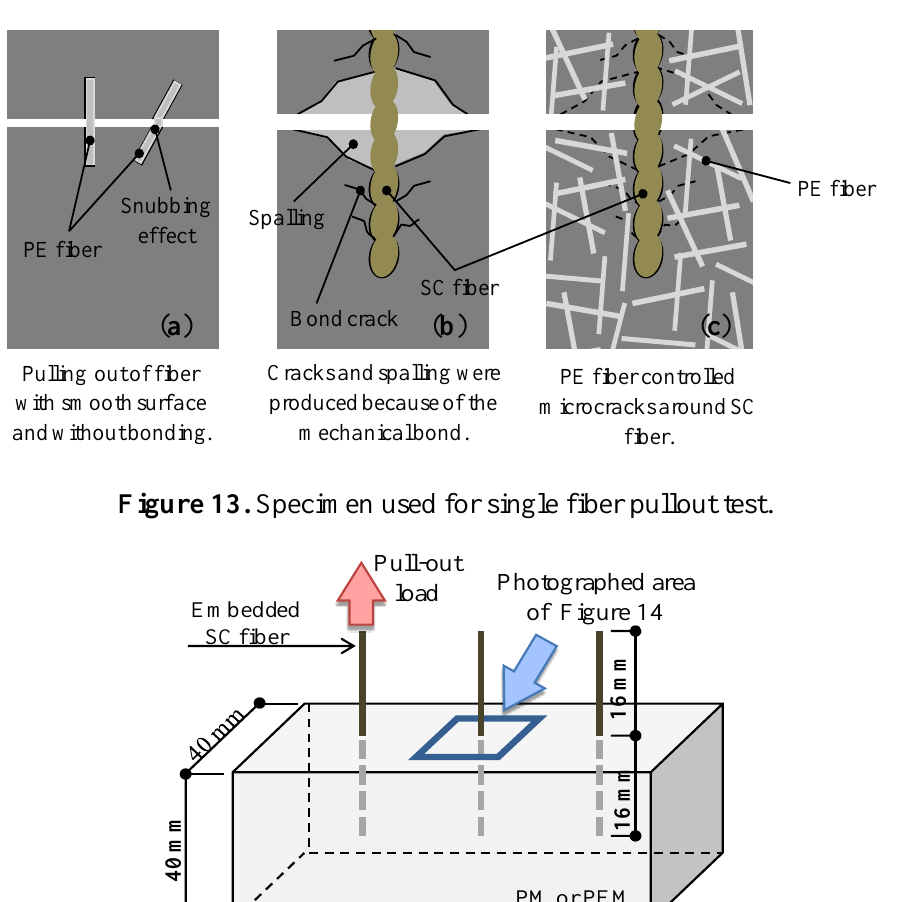
Figure 12. Schematic diagram of pullout behavior of different types of fibers in the matrix.